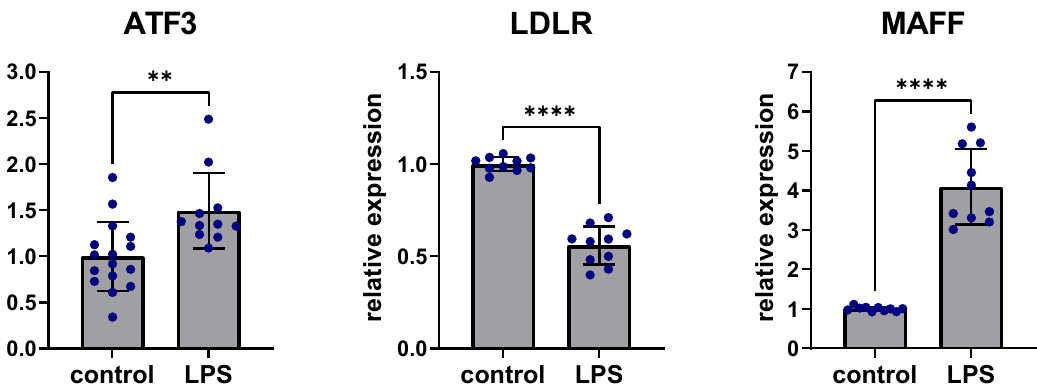
Figure 5. Perturbation of ATF3, LDLR and MAFF expression after LPS stimulation. Stimulation with 100 ng/mL LPS for 24 h led to significant upregulation of ATF3, downregulation of LDLR and up- regulation of MAFF in human Hep3B liver cells. ** p < 0.01, **** p < 0.0001. ATF3: Activating tran- scription factor 3F; LDLR: low-density lipoprotein receptor; LPS: Lipopolysaccharide; MAFF: MAF basic leucine zipper transcription factor F.